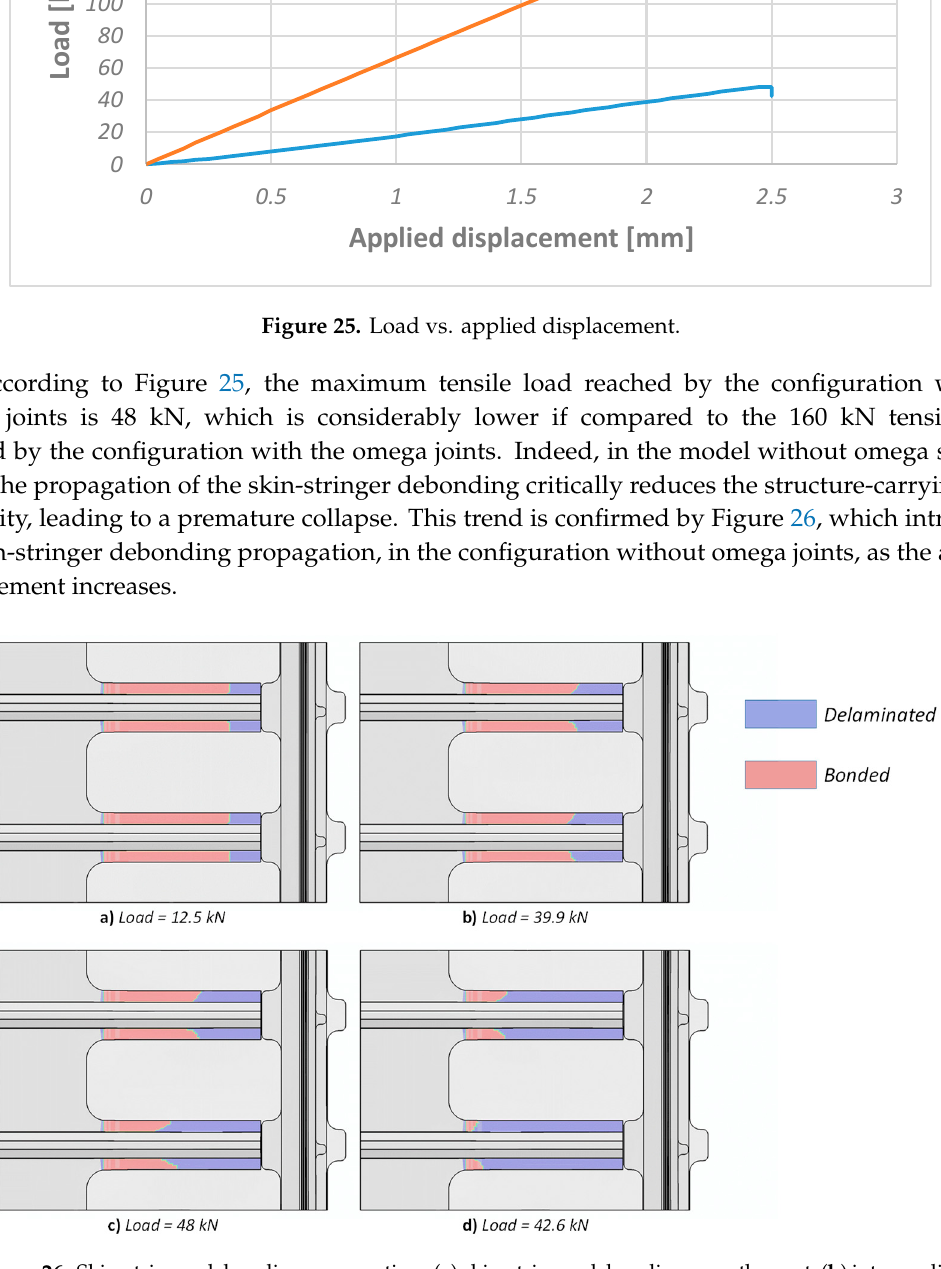
Figure 26. Skin-stringer debonding propagation. ( a ) skin-stringer debonding growth onset; ( b ) intermediate skin-stringer debonding evolution; ( c ) maximum attained load; ( d ) ultimate skin- stringer debonding.